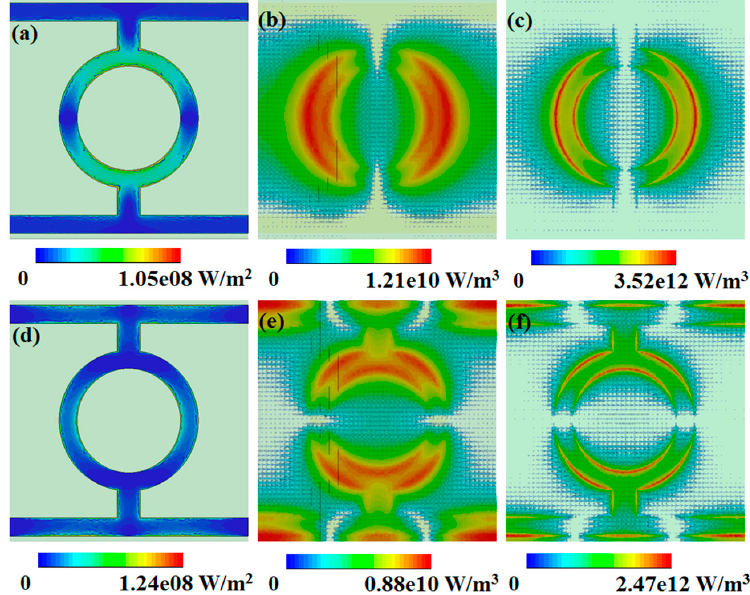
Figure 5. Calculated results for peak absorption frequency: ( a ) distribution of surface losses at the patterned copper layer at 238.4 GHz, ( b ) distribution of dielectric power loss density of the quartz plate at 238.4 GHz, ( c ) distribution of dielectric power loss density of the LC layer at 238.4 GHz, ( d ) distribution of surface losses at the patterned copper layer at 313.2 GHz, ( e ) distribution of dielectric power loss density of the quartz plate at 313.2 GHz, and ( f ) distribution of dielectric power loss density of the LC layer at 313.2 GHz.